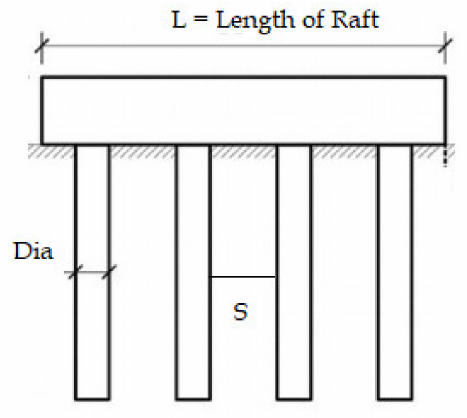
Figure 3. Geometry of the pile-raft foundation (S = spacing (variable), Dia = variable, Length = 11